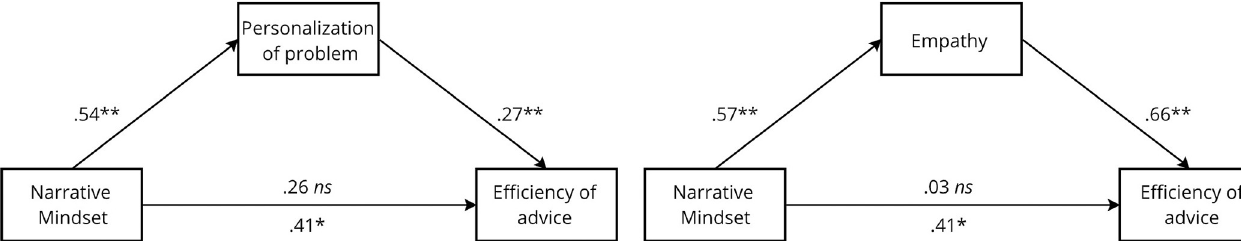
Fig 1. Mediating effect of personalization of problem and empathy on the association between narrative mindset and effectivity of advice–two separate simple mediation models (the interpersonal problem- solving study). Note : Presented regression coefficients were partially standardized for the narrative mindset predictor. The remaining were fully standardized. Coding for the independent variable: 0 –control, 1 –experimental. � p < .05. �� p < .01. ��� p < .001.